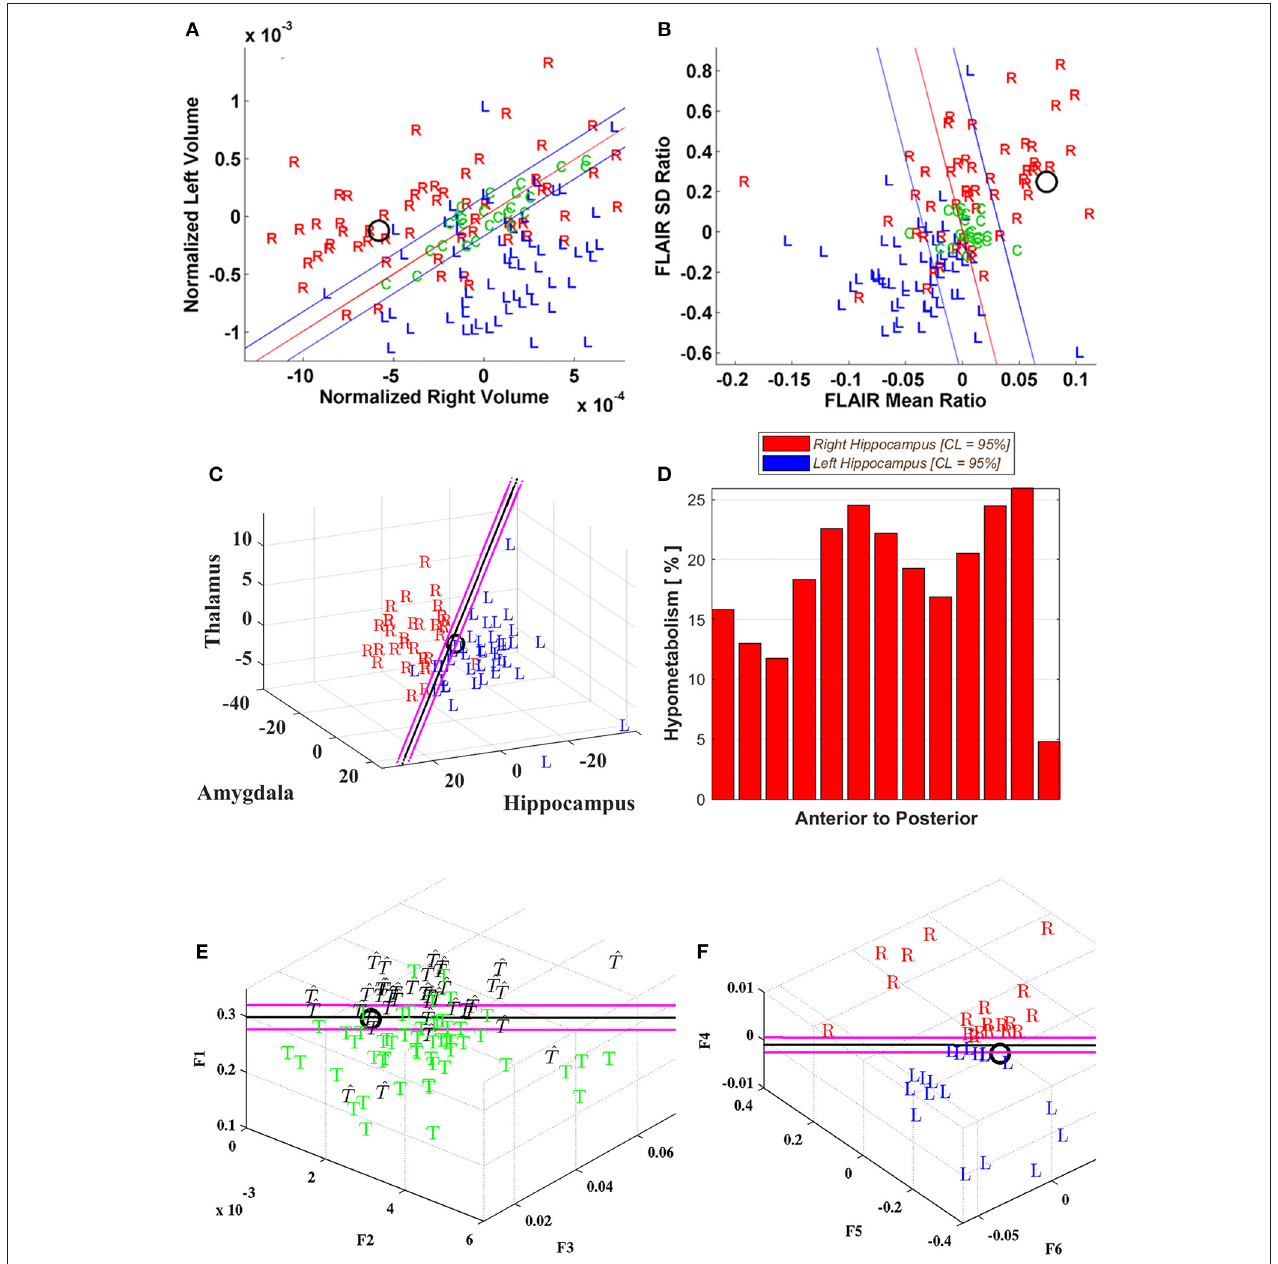
FIGURE 2 | Case P03. Quantitative neuroimaging analysis in a patient who underwent Phase I study followed by a right temporal resection achieving an Engel class 2B outcome. The models did not adequately lateralize the epileptogenic side. Hippocampal volumetry (A) and FLAIR intensity (B) scatter plots lateralized this case as right-sided (O). However, the MSA model (C) was poorly lateralizing with the prospective case immediately to the left of the decision plane (i.e., UL; Table 1 ). (D) The cross-sectional position emission tomography (PET) profile of hippocampal hypometabolism strongly showed right-sided hypointensity for this case. Diffusion tensor image (DTI) connectivity analysis was indeterminate (i.e., U; Table 1 ). The support vector machine (SVM)-based classifiers developed for (E) categorizing whether the epileptogenic area resided in the temporal lobe, T, or not, T, and (F) lateralizing the epileptogenic area, showed the prospective case to reside within the boundary domain and on the borderline, respectively. Note that the decision plane is parallel to the angle of view; hence, it is seen as a black line in two dimensions. The uncertainty boundaries are demonstrated as pink lines which are defined here to be half the maximum margin of the support vectors ( 64). The features for categorization (F1–F3) and for lateralization (F4–F6) are defined in Methods section Diffusion Tensor Image Connectivity Analysis. a prediction model for the laterality of seizure onset based order to be interpreted correctly. Using the DTI of 23 non- on HVU levels of mean diffusivity (MD) in the hippocampus epileptic subjects and 20 TLE patients who had undergone and fractional anisotropy (FA) in the posteroinferior surgical resection with Engel class 1 outcomes, we developed